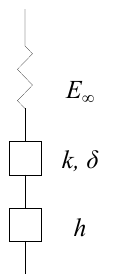
Figure 6. Huet model schematic [41].